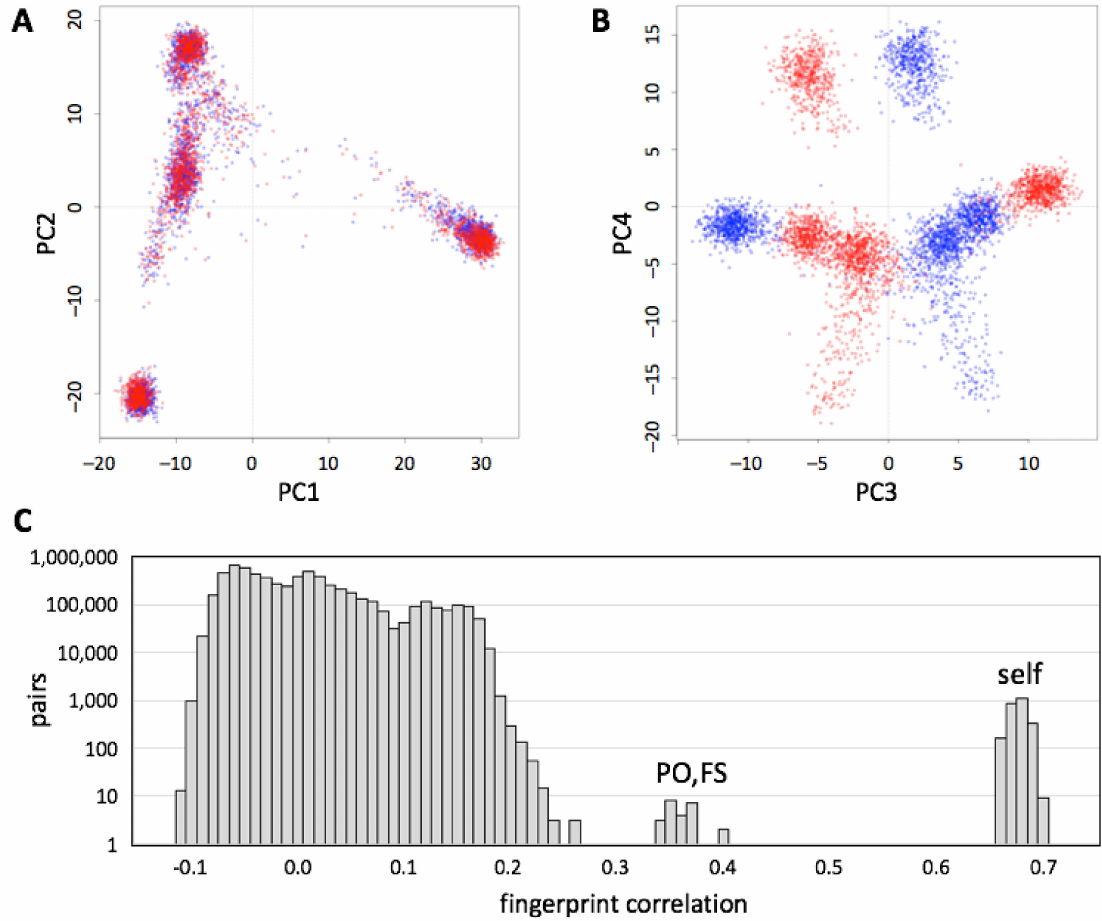
Figure 5. Comparison of genotype fingerprints relative to different SNP lists. We deduced normalized genotype fingerprints ( L = 5000) for the 1000 Genomes Project cohort using the 23andMe V2 (red) and V3 (blue) SNP lists. ( A ) First two principal components, showing population structure. ( B ) Third and fourth principal components, showing separation between the two SNP lists. ( C ) Distribution of cross-correlations between the two sets of genotype fingerprints (all possible pairs of V2 vs. V3). Comparisons between the two genotype fingerprints for the same individual (self) and comparisons between parent/offspring and full-sibling pairs (PO, FS) formed distinct, high-correlation